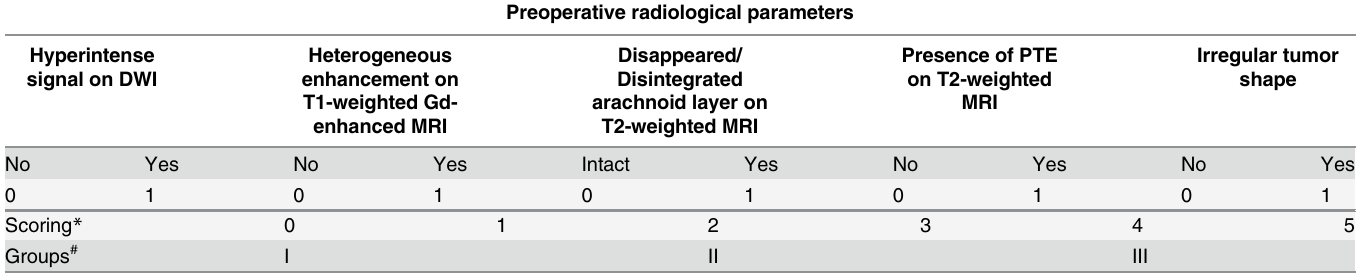
Table 1. Summary of the preoperative radiological classi fi